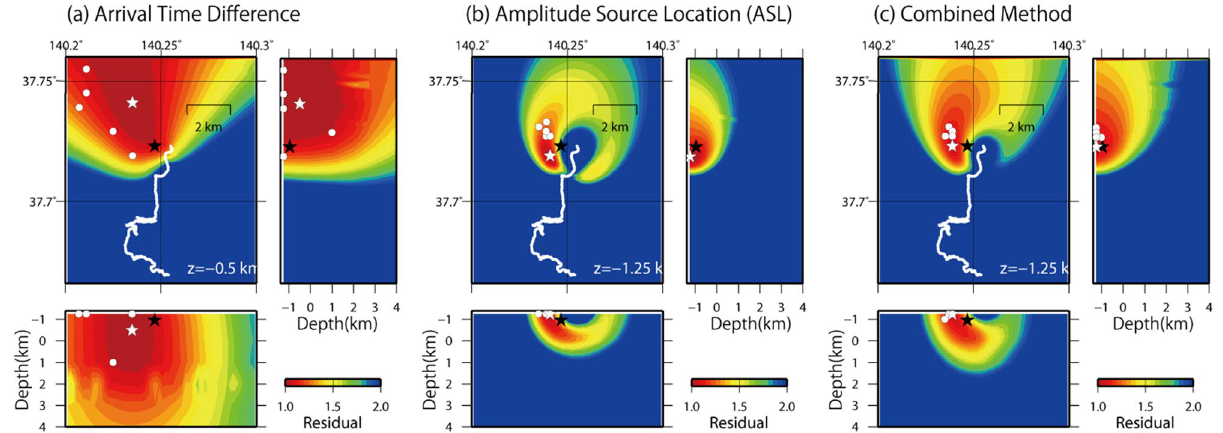
Figure 3. Source locations of the six volcanic earthquakes and spatial distribution of the residual between the observed and theoretical values for a volcanic earthquake at 12h35m on July 4, 2019. ( a ) Arrival time differences, ( b ) seismic amplitudes, and ( c ) combined method. White stars represent the estimated source locations of the earthquake on July 4 and white circles do those for the other five earthquakes. Black stars indicate the hypocenter obtained by routine hypocenter determination. White lines indicate the location of the fiber-optic cable. The residuals in ( a ) and ( b ) are normalized by the minimum residual for each method. The residual in ( c ) is S in Eq. (2). This figure was created by Generic Mapping Tools (GMT) v4.5.5 39